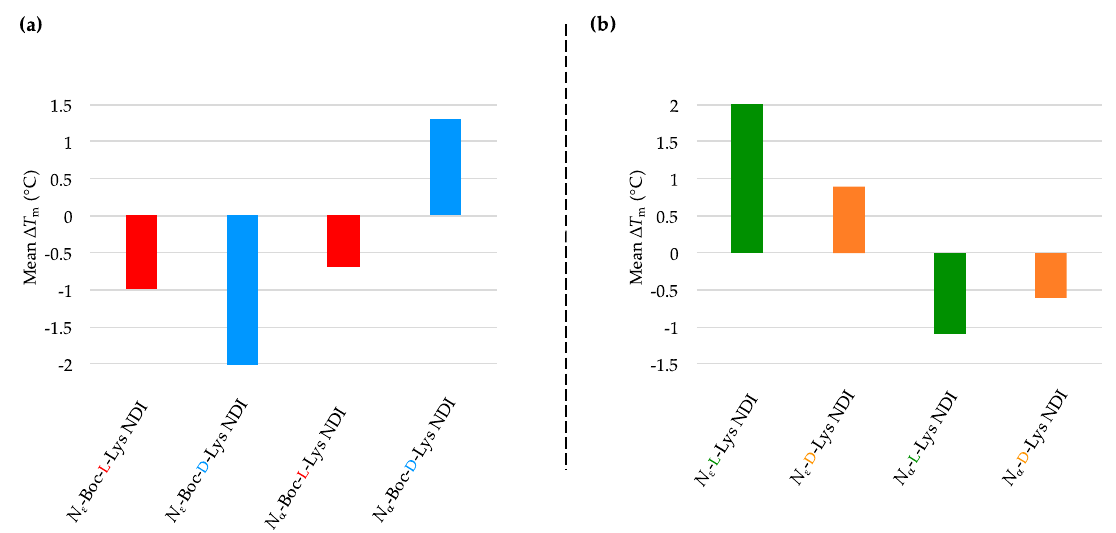
Figure 7. Graphical representations of mean ∆ T m values obtained from VT CD studies of h-TELO with 10 equivalents of ( a ) N α - and N ε -Boc- L - and D -NDIs as well as ( b ) N α - and N ε - L - and D -NDIs. Table 5. The T m values of h-TELO only compared to the T m of ( a ) h-TELO-Boc-protected-NDIs and ( b ) h-TELO-deprotected-NDIs as determined from VT CD studies.